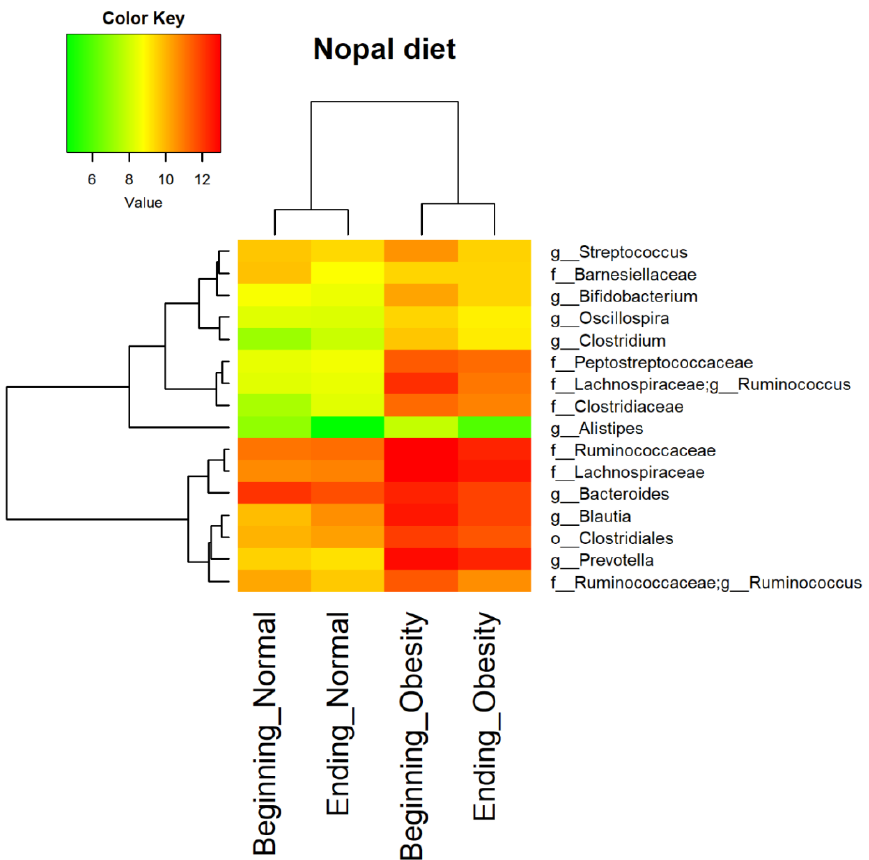
Figure 3. Bacteria with high relative abundance during nopal diet intervention. Differential abun- dance of the top 16 bacteria in fecal samples. The heat map shows differences among beginning and ending with nopal diet intervention on normal weight and obesity groups. Columns show the abundance of the top 16 bacterial taxa present in at least 95% of samples. Rows show the 16 bacteria clustered by its abundance in the group. The color key from green to red indicates differences in the natural logarithm of the absolute abundances obtained from the taxa-bar-plots .